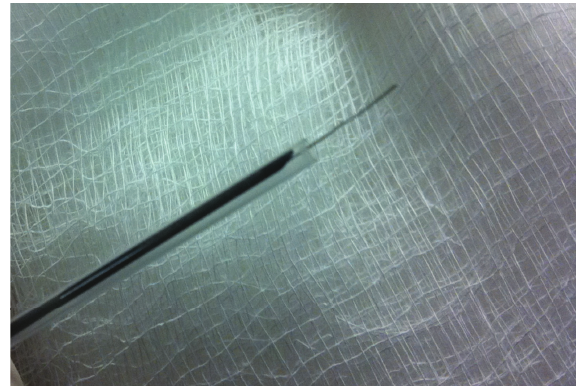
Figure 2: Habib EUS RFA probe.